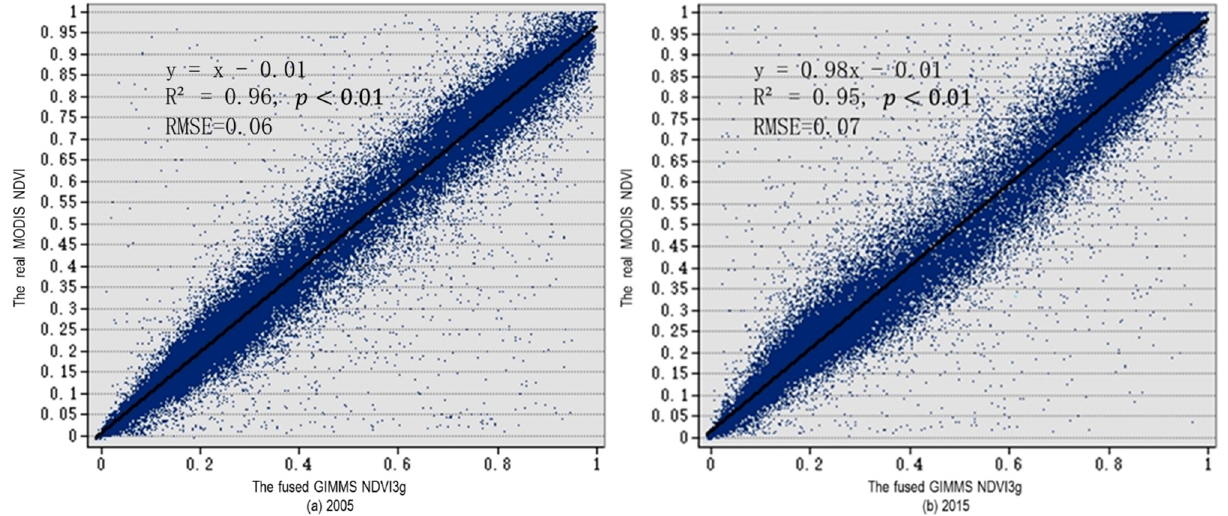
Figure 2. Scatter plot of pixel values corresponding to the fused GIMMS NDVI3g and MODIS NDVI.